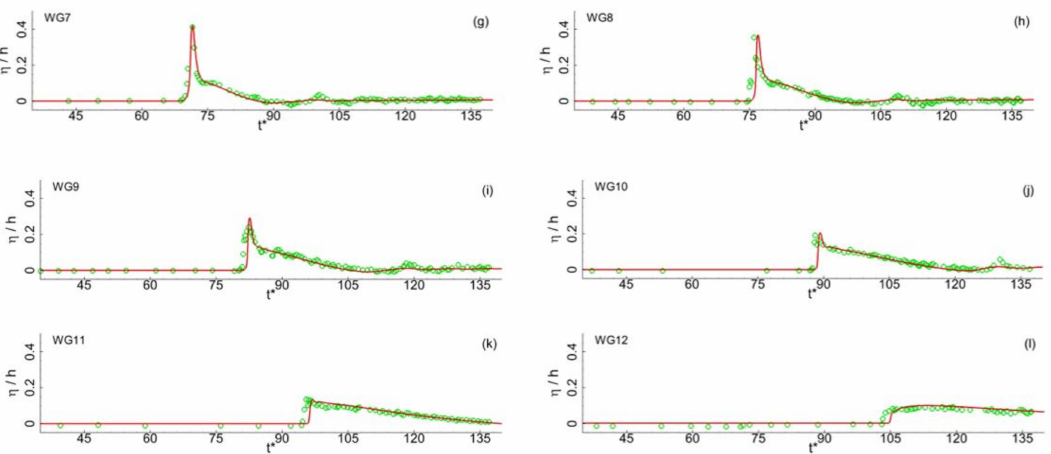
Figure 6. Comparisons of the time series of water surface elevation at different wave gauges for H/h = 0.338; ( a ) WG1; ( b ) WG2; ( c ) WG3; ( d ) WG4; ( e ) WG5; ( f ) WG6; ( g ) WG7; ( h ) WG8; ( i ) WG9; ( j ) WG10; ( k ) WG11; ( l ) WG12.